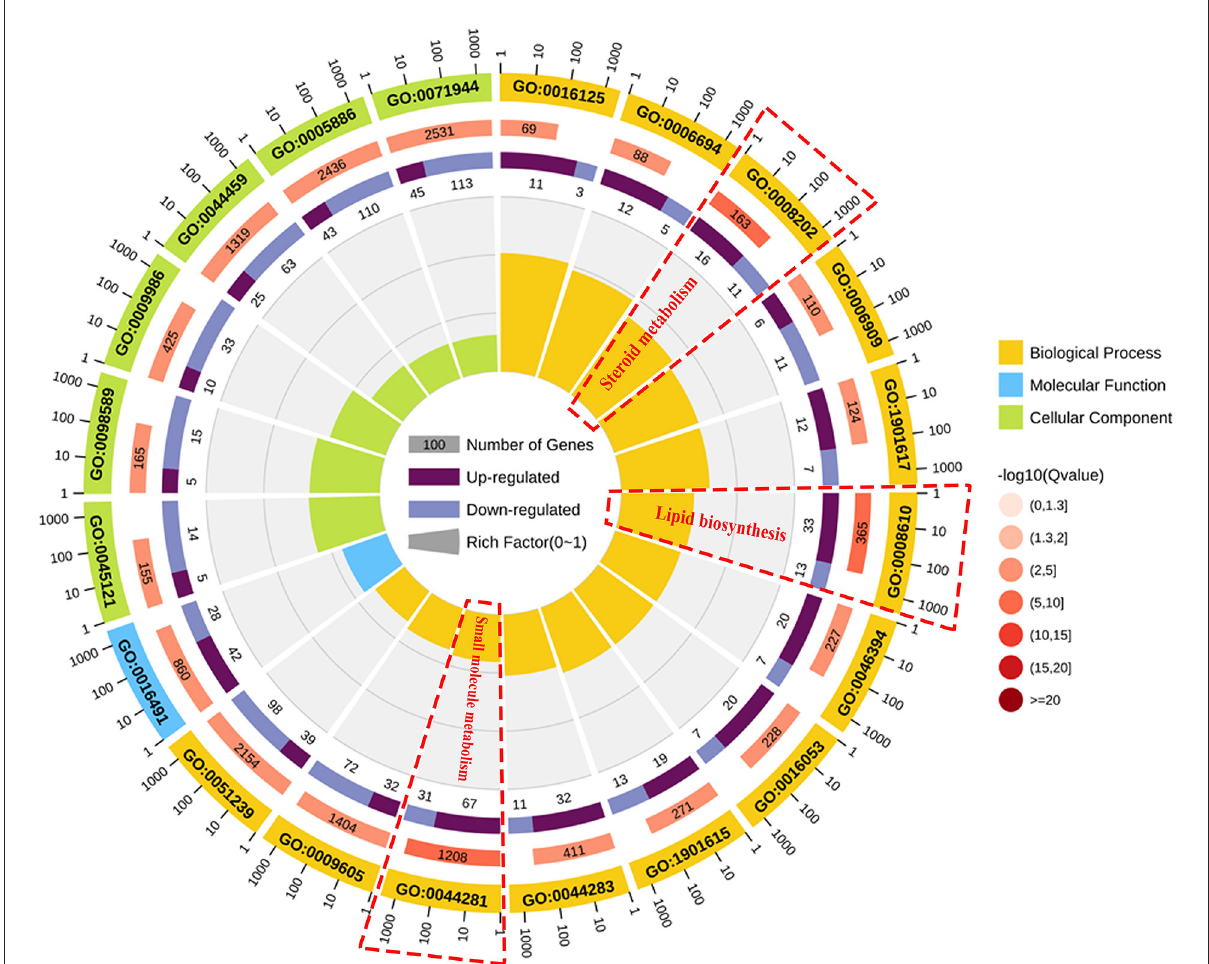
FIGURE3 Function analysis of the DEGs between the control and NCG groups based on the results of the Gene Ontology (GO) analysis method. Top 20 terms (control vs. NCG) for GO enrichment. Yellow, blue, and green represent biological process, molecular function, and cellular component,